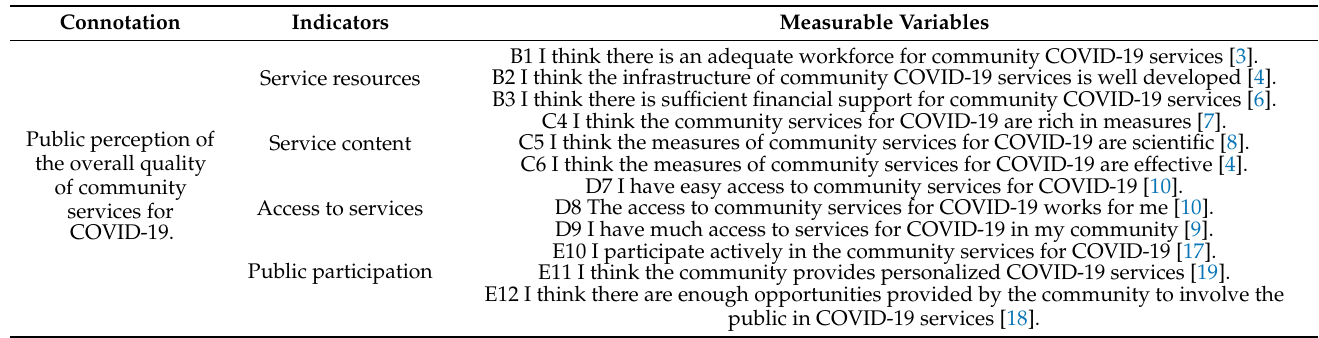
Table 2. Connotation and measurable variables of quality perception.